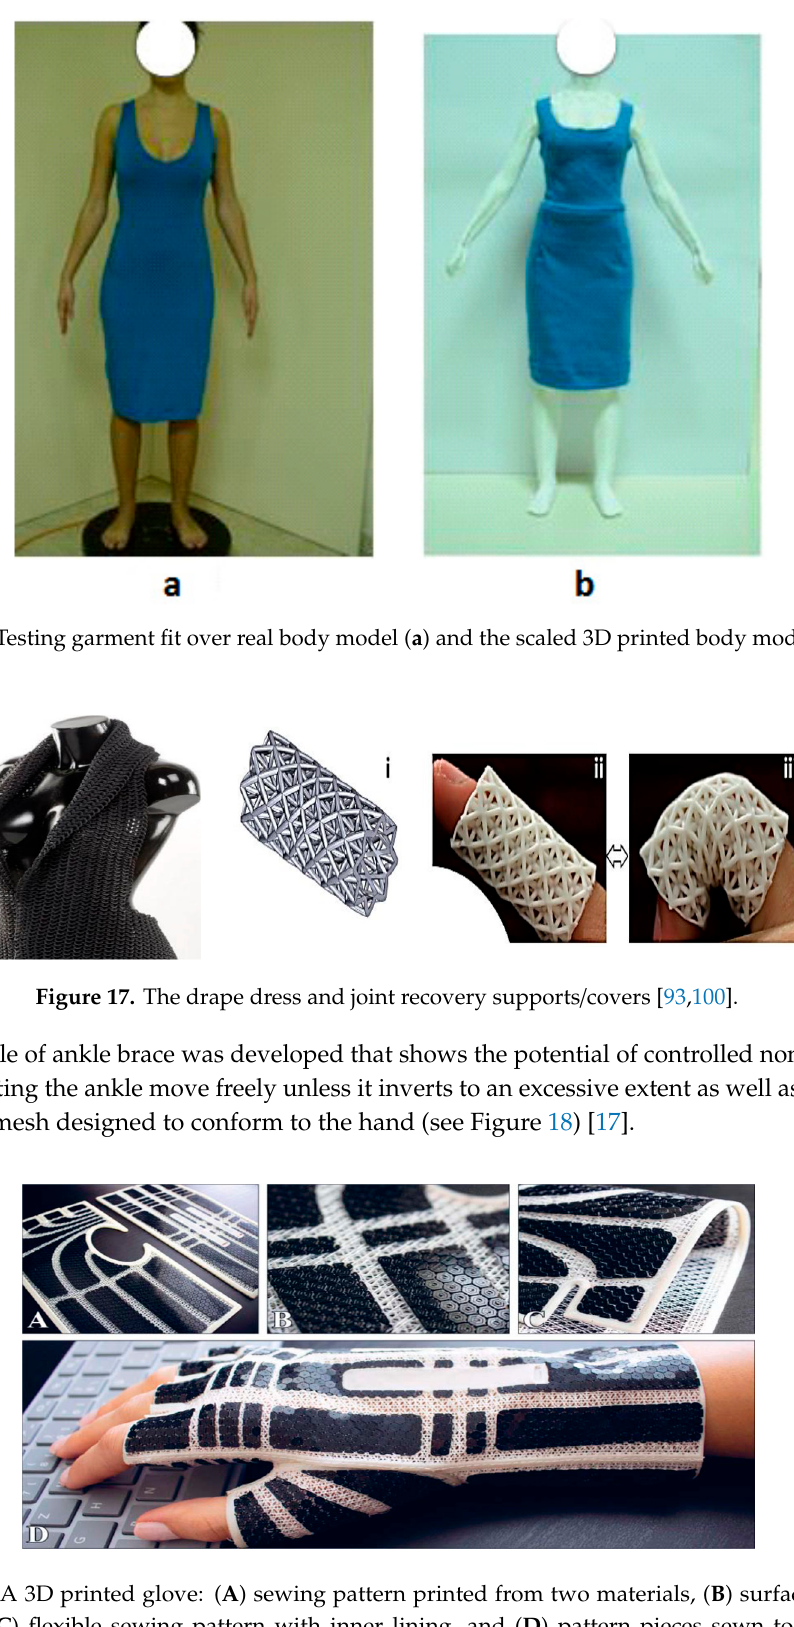
Figure 18. A 3D printed glove: ( A ) sewing pattern printed from two materials, ( B ) surface design of glove, ( C ) flexible sewing pattern with inner lining, and ( D ) pattern pieces sewn together to three-dimensional garment